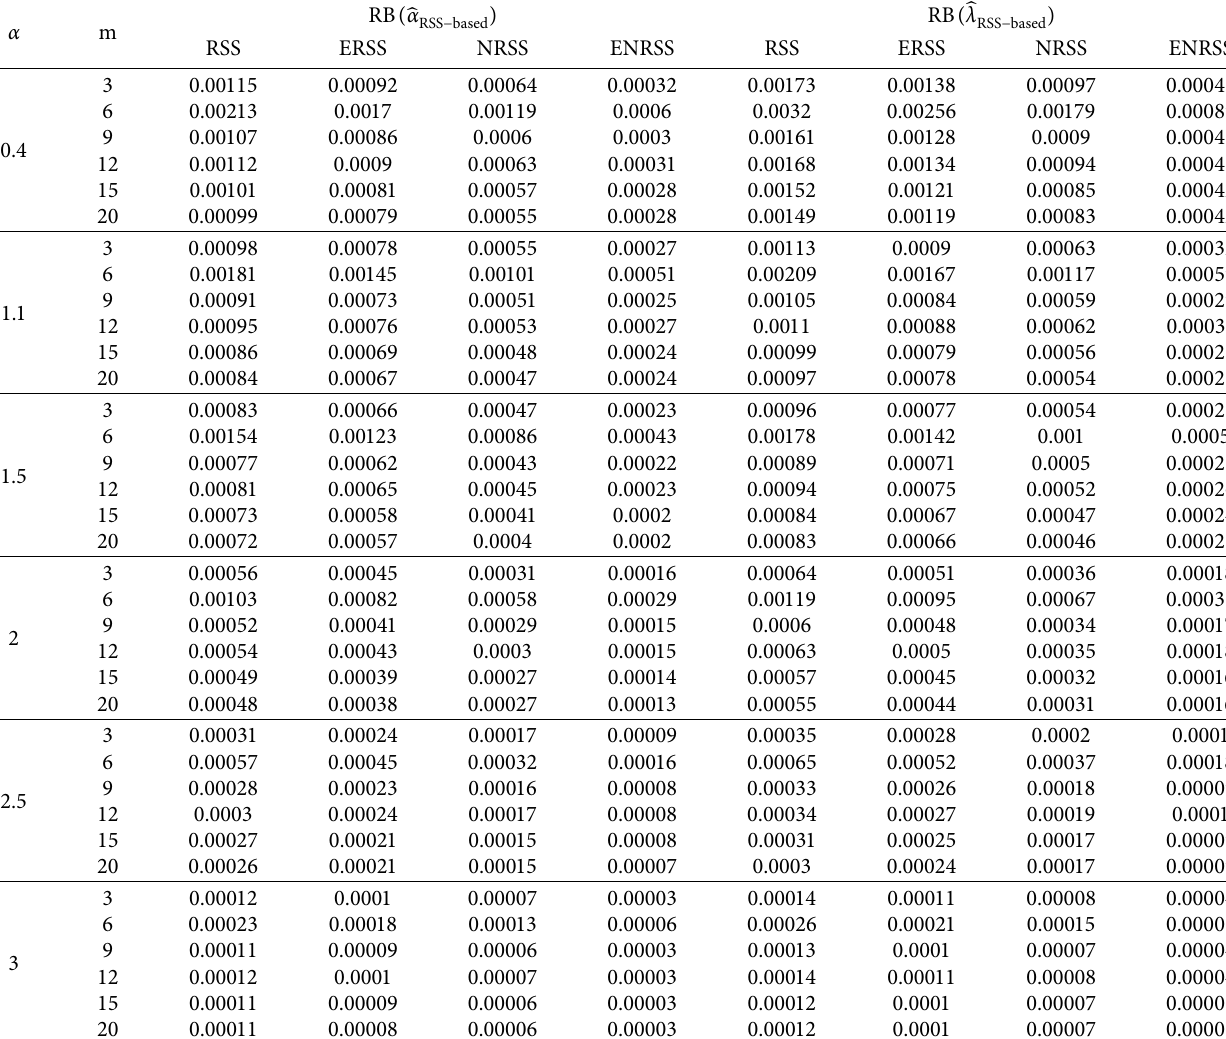
Table 2: Relative bias for RSS-based estimators for different sampling plans and INH distribution with scale parameter λ � 1. α